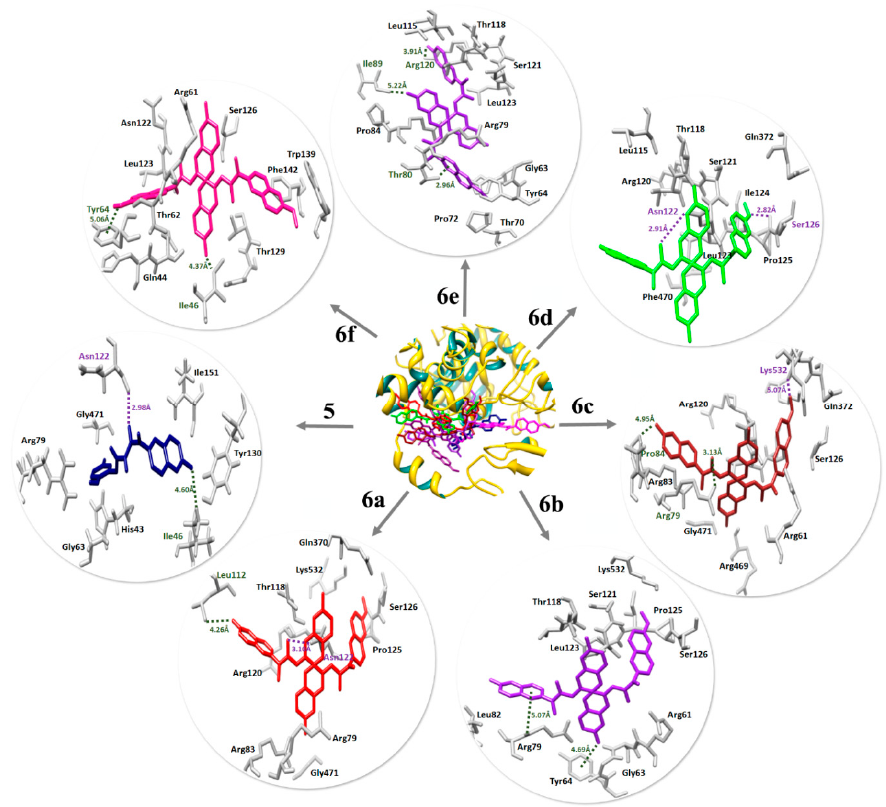
Figure 3. Docking of synthesized compounds. The ligand structures ( 6a – f ) are justified in red, purple, brown, green, light purple, and pink colors, respectively. The reference structure is highlighted in